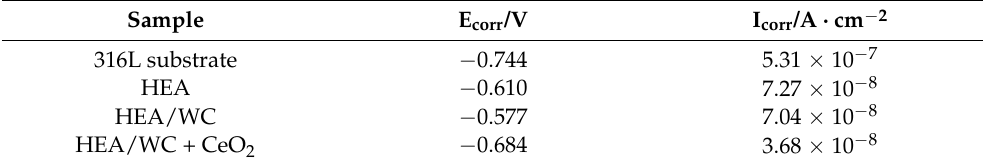
Figure 11. Curves of electrochemical corrosion results: ( a ) polarization curves; ( b ) Nyquist diagram; ( c ) Bode plot. Table 5. Experimental results of self-corrosion performance in pH =